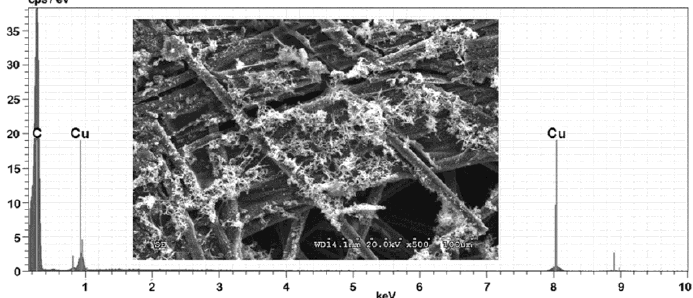
Figure 4. SEM micrograph and EDS analysis of electrodeposition at pH 1.5 on Toray paper carried out with a fixed working electrode potential at −1.6 V vs. Ag/AgCl during 600 s in synthetic and leaching solutions.